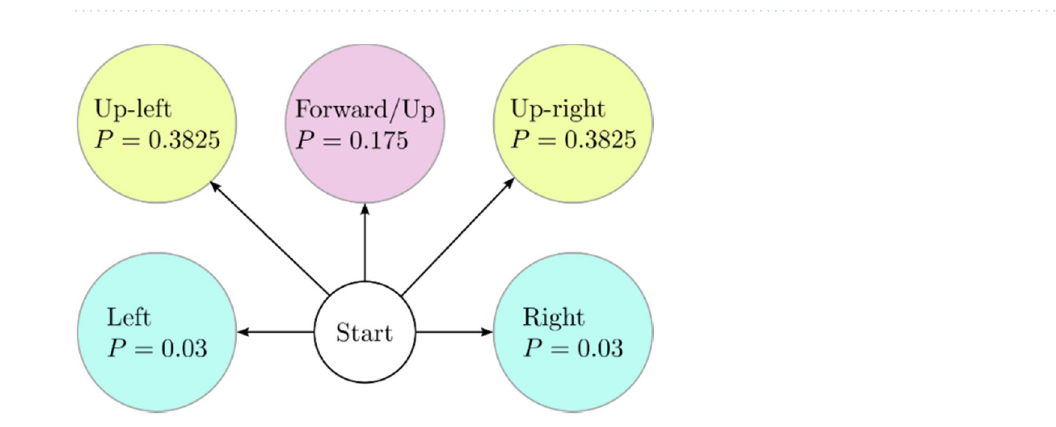
Figure 11. Probability distributions of crack distribution at different y -levels (Random Walker #1): ( a ) Ribbon- plot view; ( b ) 2D congregated curves.